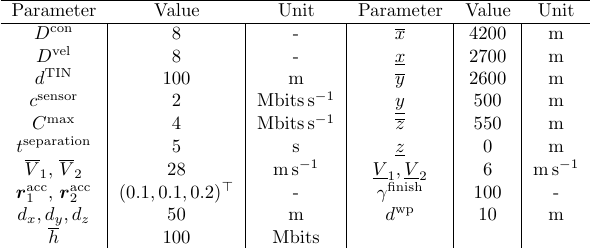
Table 3: MILP parameters